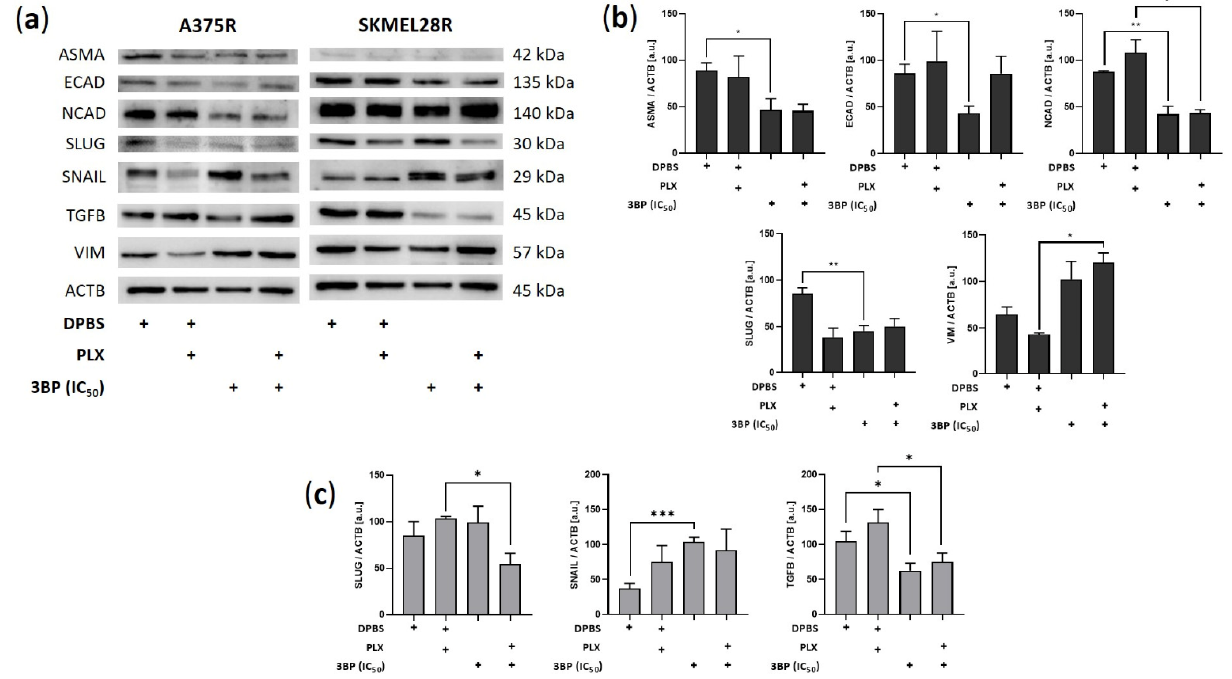
Figure 6. Expression of epithelial-mesenchymal transition (EMT) markers in vemurafenib (PLX)-resistant melanoma cells treated with 3BP for 24 h. ( a ) Western blot analysis of the levels of ASMA, ECAD, NCAD, SLUG, SNAIL, TGFB, and VIM in PLX-resistant melanoma cells treated with IC 50 3- bromopyruvate (3BP), either alone or combined with PLX (4.5 µM for A375R cells and 6.0 µM for SKMEL28R cells), for 24 h. ( b ) Quantification of immunoblots normalized to ACTB levels in A375R melanoma cells. ( c ) Quantification of immunoblots normalized to ACTB levels in SKMEL28R melanoma cells. The y -axis represents arbitrary units [a.u.]. The positive signs in the bar charts indicate the presence of a defined treatment. Data represent the mean ± SEM of at least three independent experiments. * p ≤ 0.05; ** p ≤ 0.01; *** p ≤ 0.001. 3. Discussion Tumors present high bioenergetic and biosynthetic demands [41]. For this reason, they are commonly highly dependent on glycolysis [42] and glutaminolysis [43]. These demands are even more prominent in chemoresistant cells since they require additional resources to manage chemotherapeutic stress [37,38]. Both PLX, a drug able to decrease proliferation [44], and 3BP, a potent Warburg effect inhibitor [33], act upon different pathways of the known hallmarks of cancer [45]. Therefore, taking advantage of the interactions between oncogenic and metabolic pathways [46], we evaluated whether the combination regime PLX/3BP might be an interesting anticancer strategy. In general, 3BP monotherapy has shown promising results in arresting melanoma aggressiveness, especially in highly glycolytic cell lines. To our knowledge, this study is the first addressing the combination of these drugs in PLX-resistant melanoma cell lines. Melanoma is one of the most heterogeneous types of cancer [47], presenting a high metabolic diversity, which can impact clinical response and generate drug resistance [48]. Therefore, to extrapolate the obtained results to tumors with different metabolic profiles, metabolic characterization was performed to ensure the metabolic diversity of the cells used in the present study. Comparatively, the A375R cell line exhibited considerably low expression of GLS (suggesting a low glutaminolytic activity) and upregulated glycolysis- related proteins, such as GLUT1 and PDK. In contrast, the SKMEL28R cell line showed no predominance on glycolytic or glutaminolytic pathways, albeit presenting a high comparative expression of LDH5 and MCT4. These metabolic differences seem to have